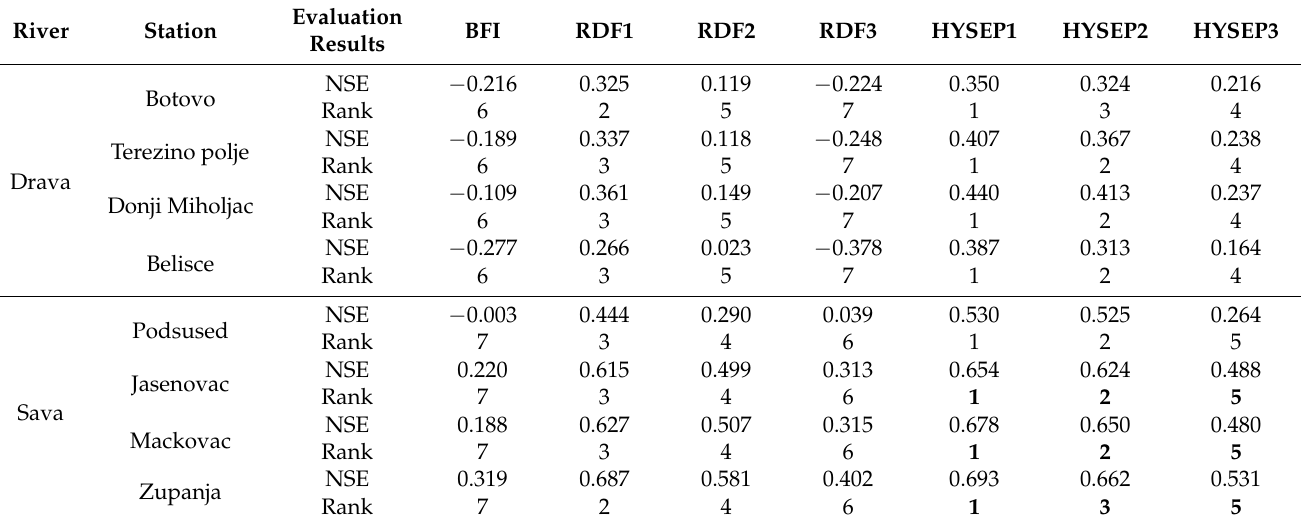
Table 4. Evaluation of 7 baseflow separation methods using the Nash–Sutcliffe efficiency